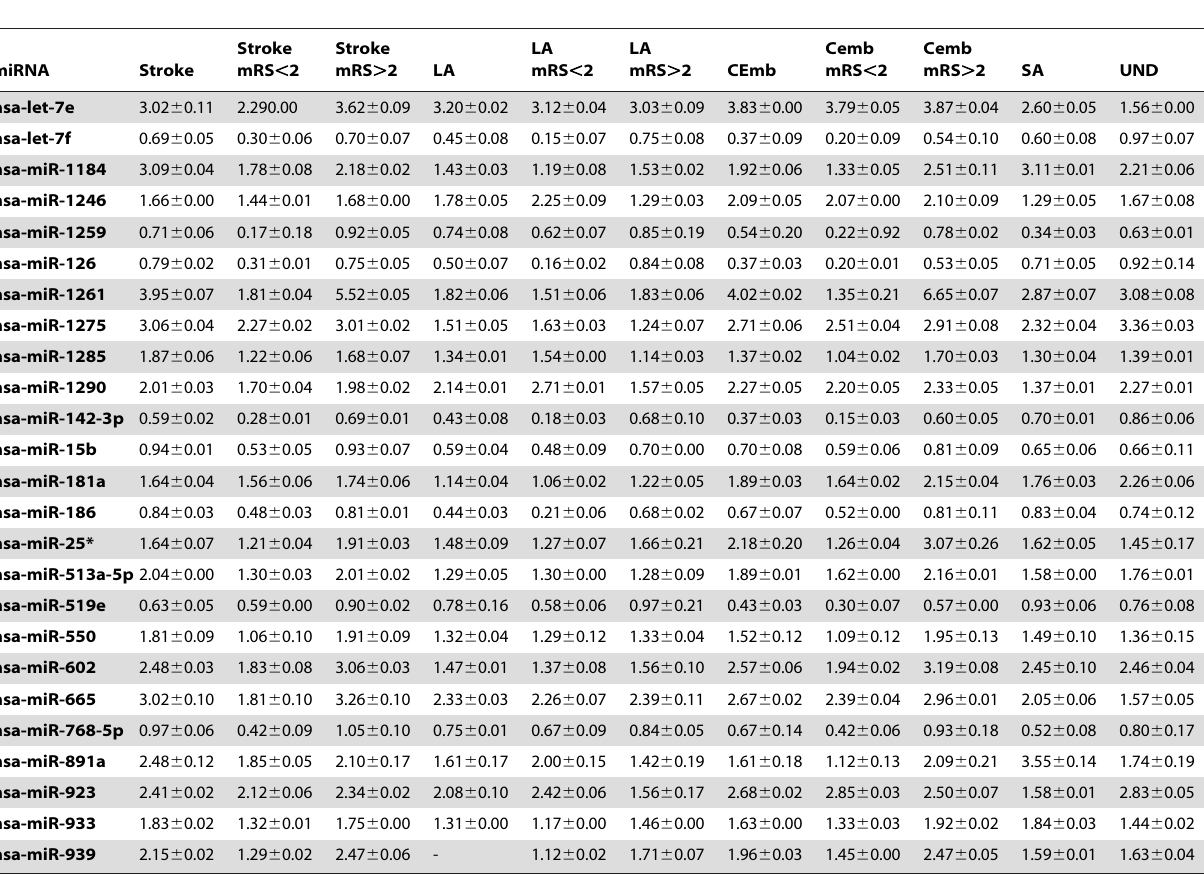
Table 2. microRNAs that show similar expression among the various stroke samples.